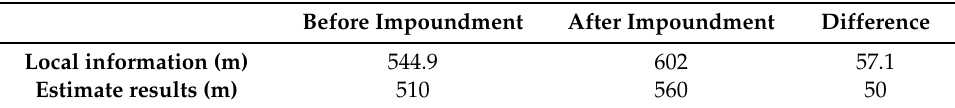
Table 4. Comparison of impoundment height of Jinghong